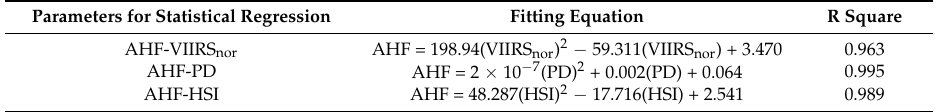
Table 4. Comparison of three statistical regression models for county-scale AHF estimation. Parameters for Statistical